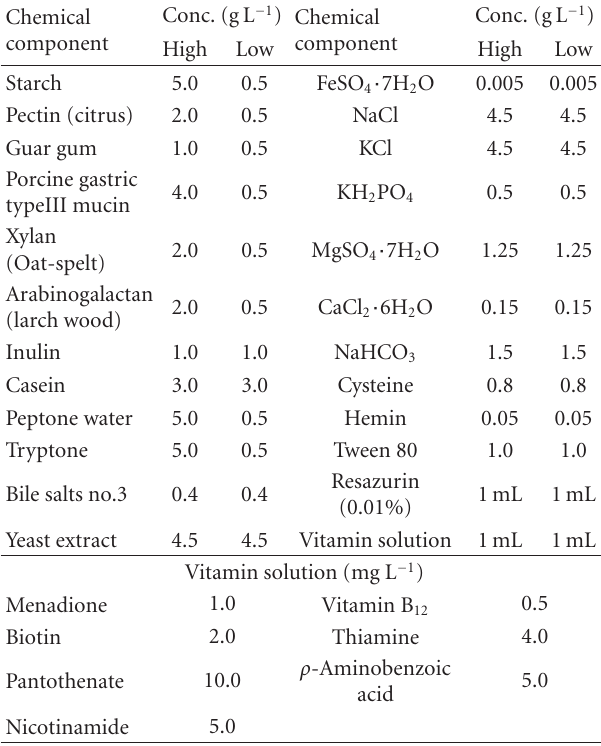
Table 1: Medium components for the optimal growth of